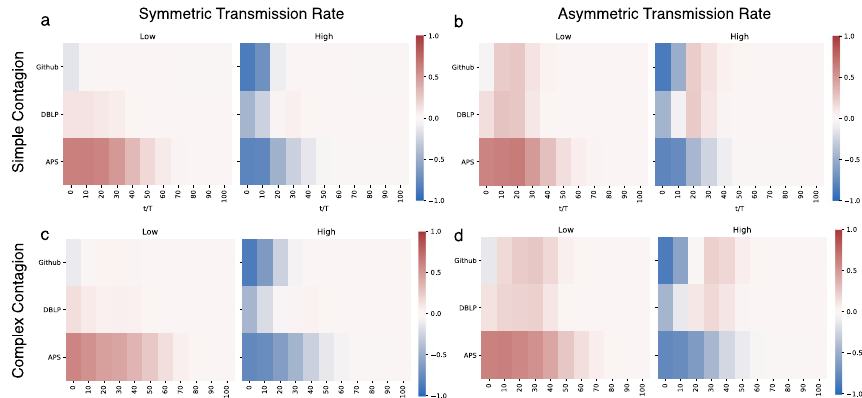
Fig. 8 Information spreading equality of real networks. Recall that we plot the spreading equality with low and high minority seeding portions. Each plot is a heatmap, where the x‑axis represents the relative time t / T , the y‑axis represents the different real‑world networks, and the color represents � I ( t / T ) while � I ( t / T ) = 0 represents equality. For Github, we find that initially � I ( t / T ) < 0 for high minority seeding portion and � I ( t / T ) ≈ 0 for low minority seeding portion, indicating that majority nodes don’t have many advantage. This is because Github has the smallest minority portion, and this is consistent with the observation for influence on equality across different m values (see Fig. 5). Across all process settings, we find that APS takes the longest to reach equality, which is consistent with our previous observation that APS is less equal in degree and has a higher homophily level. DBLP is the most equal in information access, which is consistent with lower homophily. We find that the information access equality landscape depends on different process settings. For example, under asymmetric transmission rate, we notice that � I ( t / T ) becomes positive for Github and DBLP under high seeding portion, which is not the case under symmetric transmission rate. We also find that achieving equality is much harder under complex contagion and asymmetric transmission